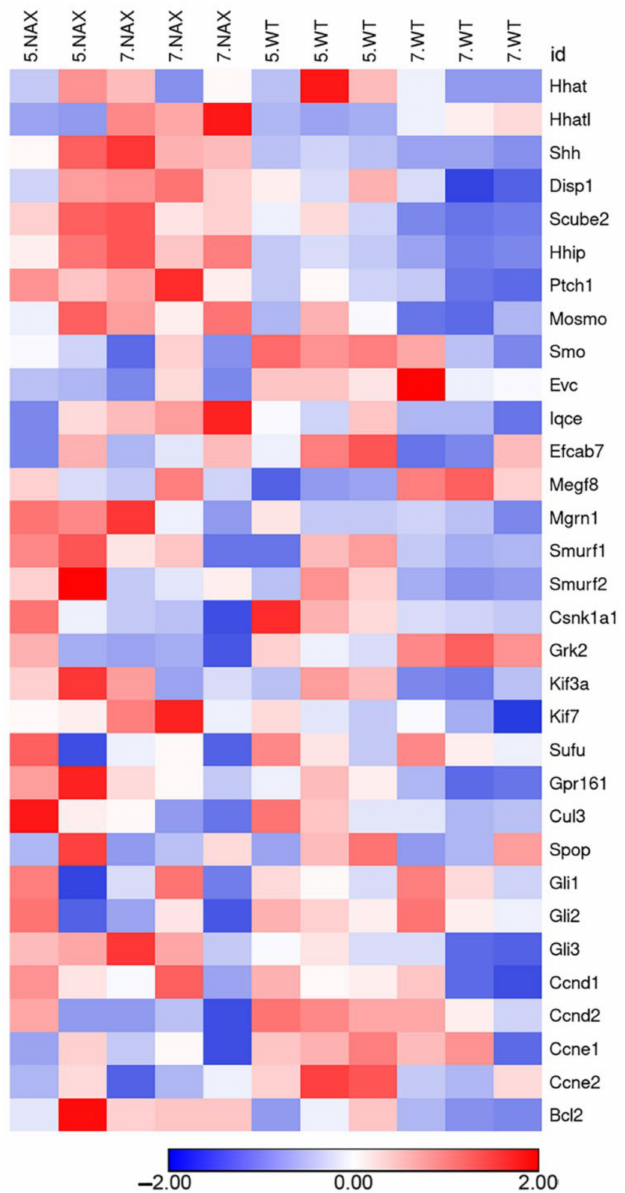
Figure 7. Heat map analysis of SHH pathway in the nax cerebellum at P5/P7. The rows of the heat map represent the genes of interest and the columns represent the experimental samples. Each cell is colored based on the level of expression of that gene in that sample. This heat map analysis shows color-coded expression levels of up (red)- and down (blue)-regulated genes. The data show that SHH signaling pathways are dysregulated in the nax